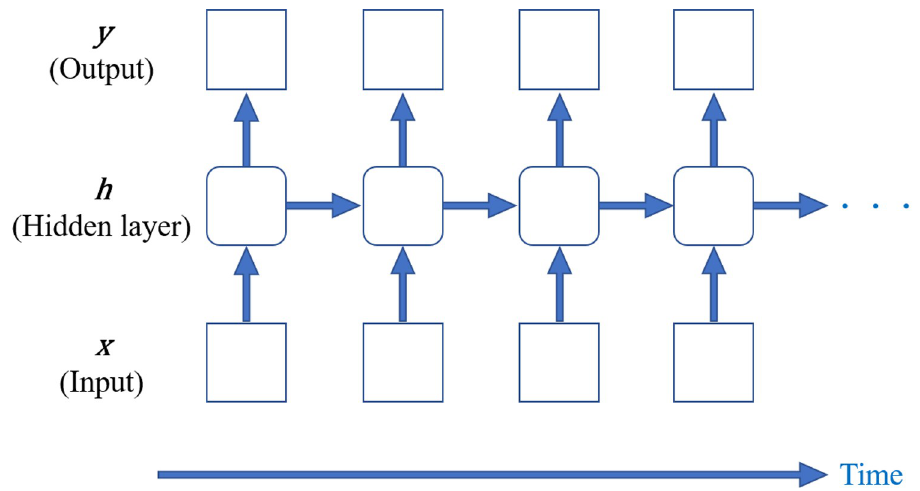
Fig 7. Schematic diagram of a recurrent neural network. In the diagram, x is the input, h is the hidden layer, and y is the output. The RNN learns by passing the weights of the hidden layer to the next hidden layer in the forward direction.